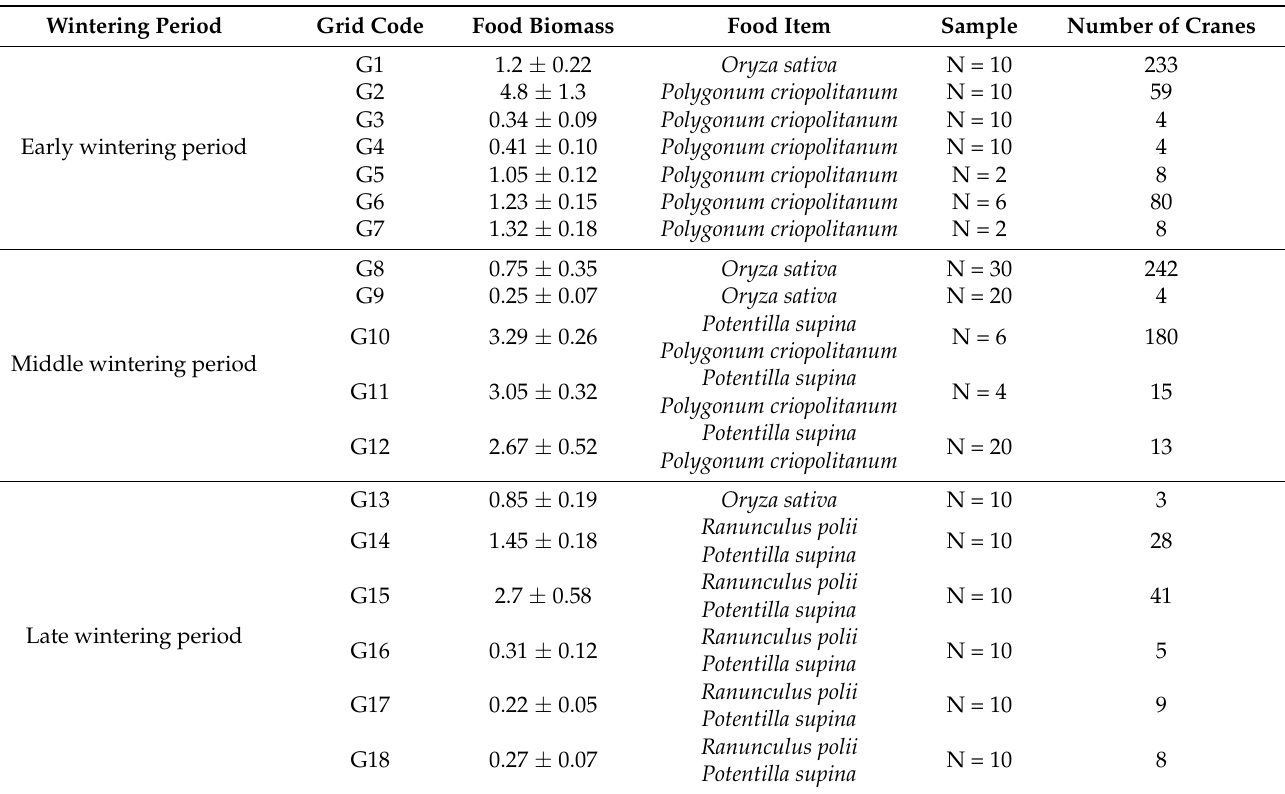
Table A1. The number of cranes, food biomass and item in the grids at Shengjin Lake (The food item was the main food resources for cranes).